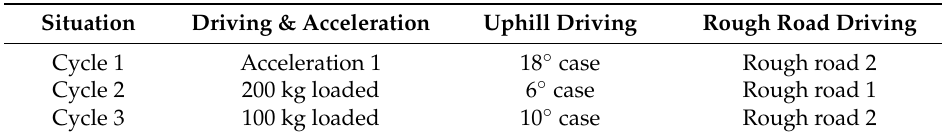
Figure 14. Driving cycle based on actual driving data. Table 5. Configuration of driving cycles. Table 5. Configuration of driving cycles.